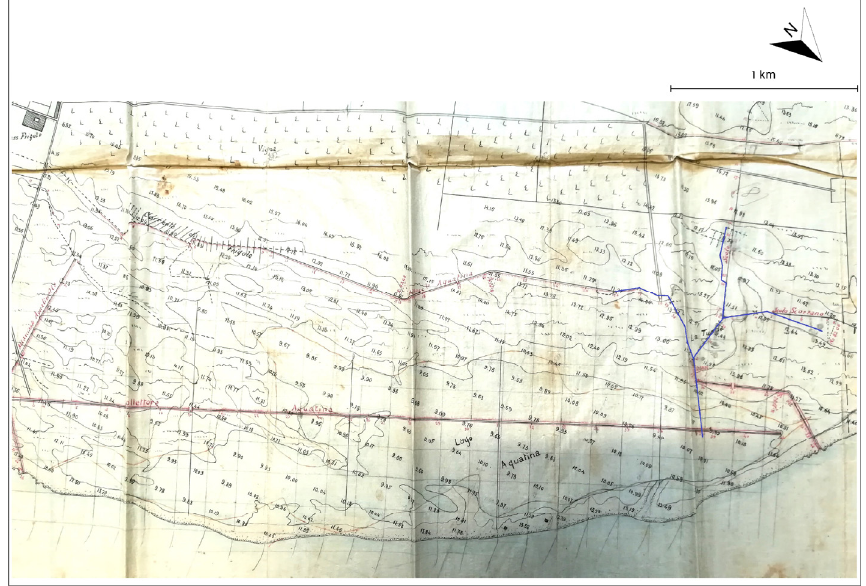
Figure 3. Extract of the project dated 19 July 1900 (signed by Eng. Luigi Libertini, Gaetano and Giulio Bernardini and presented by Eng. Fiorentino, head of the Civil Engineer, in April 1903; source: Envelope 26, Fasc. 126, State Archive of Lecce). On the right side of the map, the path designed for the Giammatteo River is visible. Originally the river consisted of three branches (here evidenced with blue lines), gathered in the area called “la tunda” , which ended directly in the Acquatina di Frigole lagoon. The project instead provided that the mouth was subject to a canalization that went around the Acquatina di Frigole lagoon and ended at sea south of the Torre Chianca.